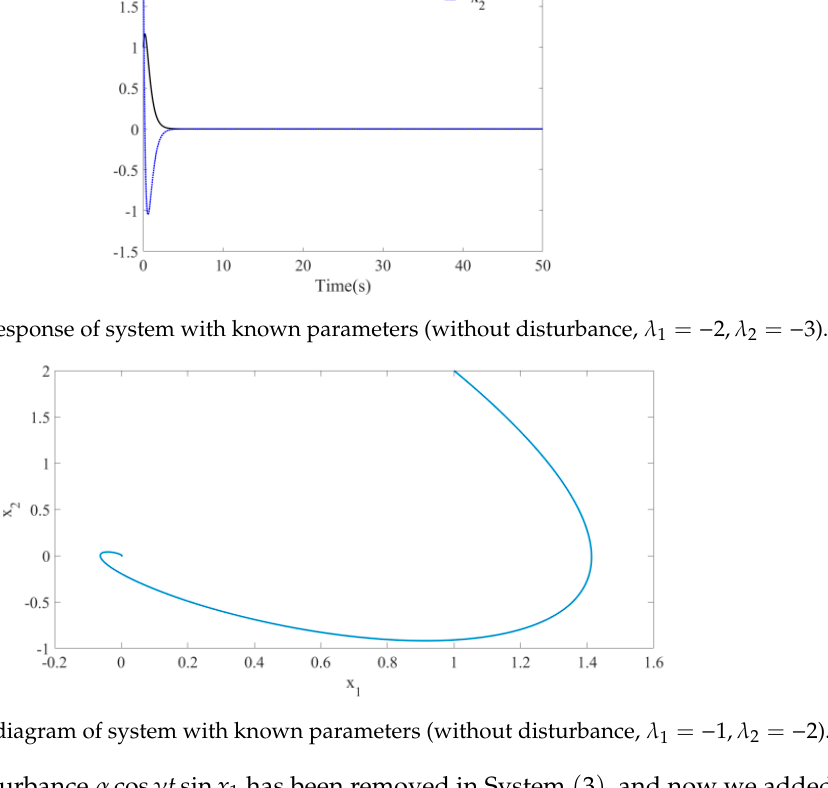
Figure 7. Phase diagram of system with known parameters (without disturbance, λ 1 = − 1, λ 2 = − 2).